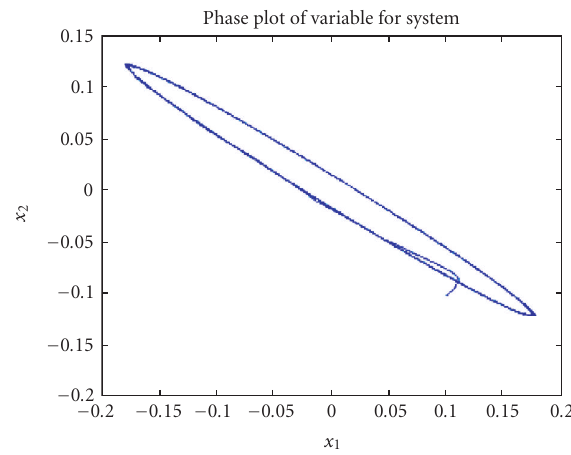
Figure 4.5. Time response of state variables x 1 ( t ) and x 2 ( t ) for system (4.1) under a 1 = 1 . 75, a 2 = 0 . 5, b 1 = 0 . 2, b 2 = − 0 . 4, τ = 18, σ = 0 . 5 τ